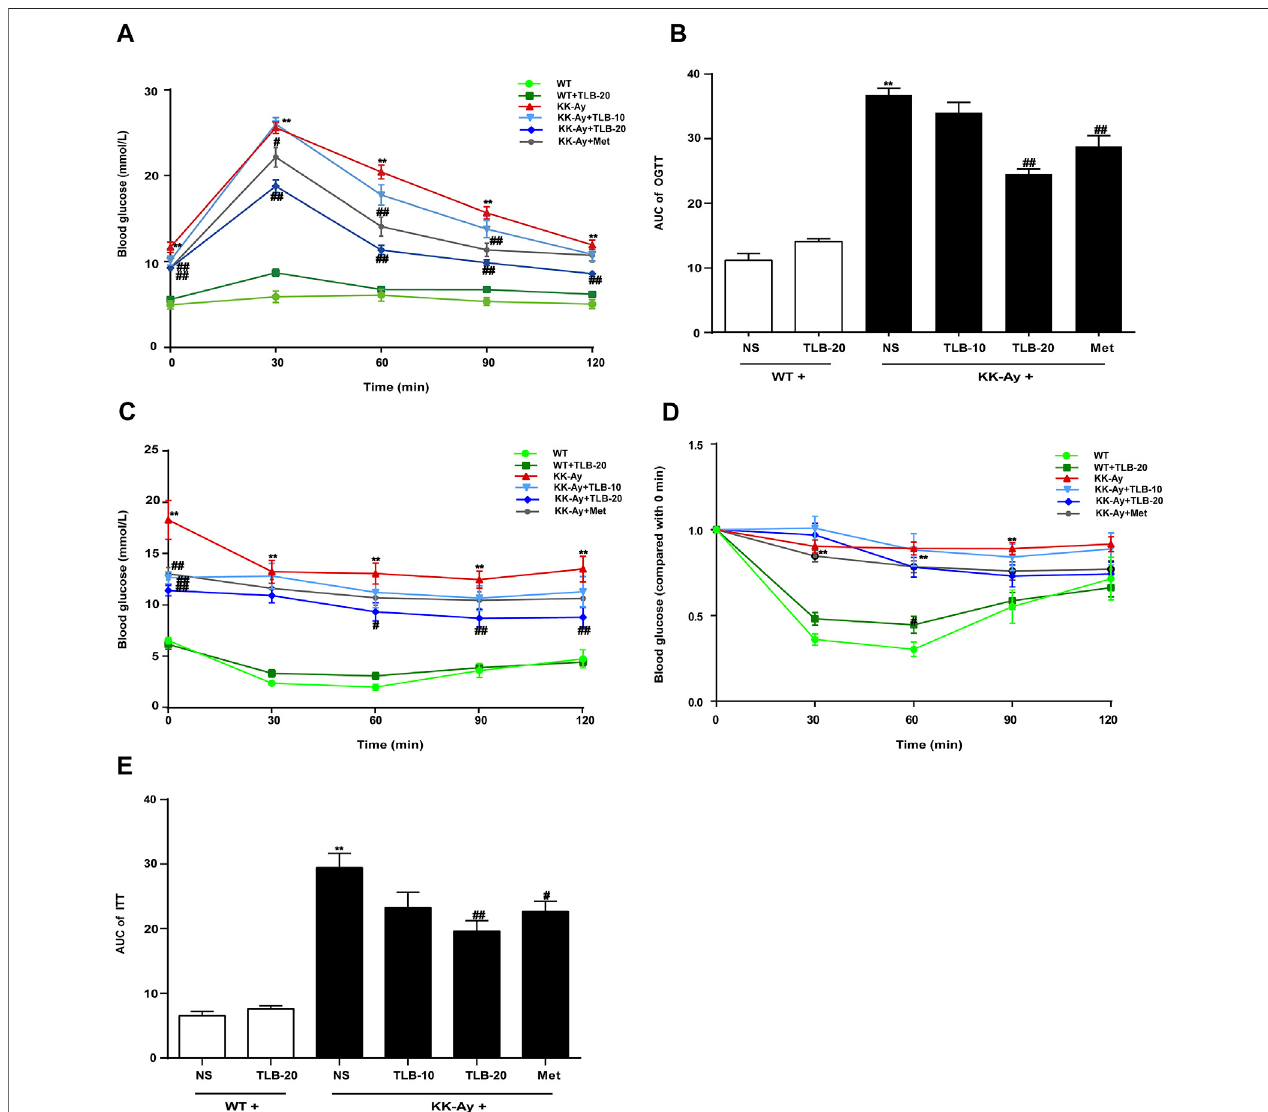
FIGURE 2 | TLB improved glucose tolerance and insulin tolerance of KK-Ay mice. (A) The blood glucose curve of OGTT. (B) The AUC of OGTT. (C) The blood glucose curve of ITT. (D) The percentage of blood glucose (compared with 0 min) curve of ITT. (E) The AUC of ITT. **p < .01 vs. WT group; # p < .05, ## p < .01 vs. KK-Ay group; n = 9 – 10 per group, mean ±